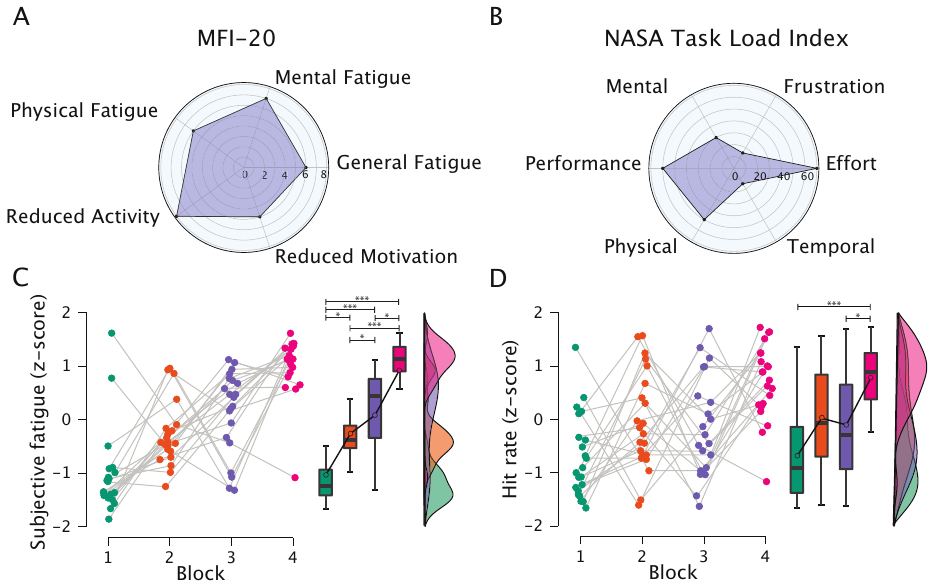
Figure 2. Results of the behavioral data analysis: ( A ) Median values for the scales of MFI-20 in the group of subjects; ( B ) Median values for the scales of NASA-TLX in the group of subjects; ( C ) Subjec- tive fatigue (z-score); ( D ) Hit rate (z-score). Dots correspond to individual subjects, while box and whisker plots show values averaged over the blocks of the experiment. The symbol * denotes statis- tical significance in post hoc analysis using t-test with Holm’s correction for multiple comparisons (*— p < 0.05, ***— p <